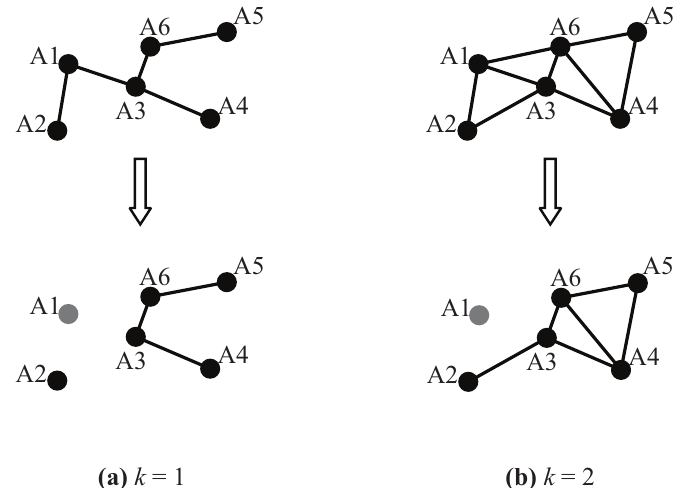
Figure 2. The effect of connectivity k on a network, ( a ) the change of a single connectivity network after single failure node appears; ( b ) the change of a biconnectivity network after single failure node